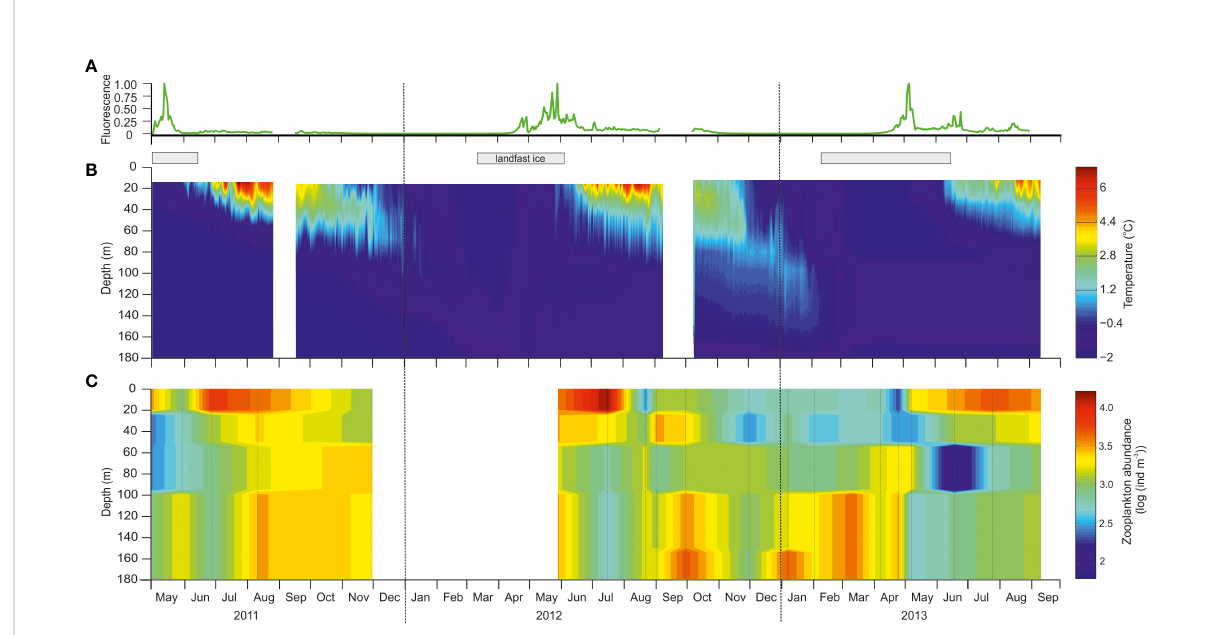
FIGURE 2 Seasonal development of environmental parameters and zooplankton abundance in the water column at station BAB in Billefjorden during the study period from May 2011 to September 2013. (A) Seasonal variability in fl uorescence (normalized between 0 and 1) measured by a SeaPoint fl uorometer placed at 28 m depth on the mooring line deployed close to station BAB in Billefjorden. (B) Seasonal variability in temperature (°C) based on several temperature loggers along the mooring line deployed close to the station. White fi eld indicates gaps in measurement due to moorings being serviced. Gray bars on top indicate periods of ice cover. (C) Seasonal variability in total zooplankton abundance (log ind. m − 3 ), there white fi eld represent no data